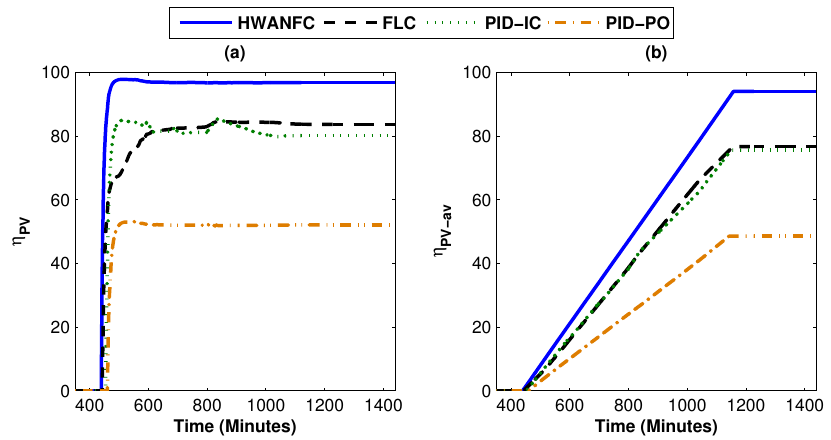
Figure 8. PV MPP tracking efficiency comparison: ( a ) η PV , ( b ) η PV - av .